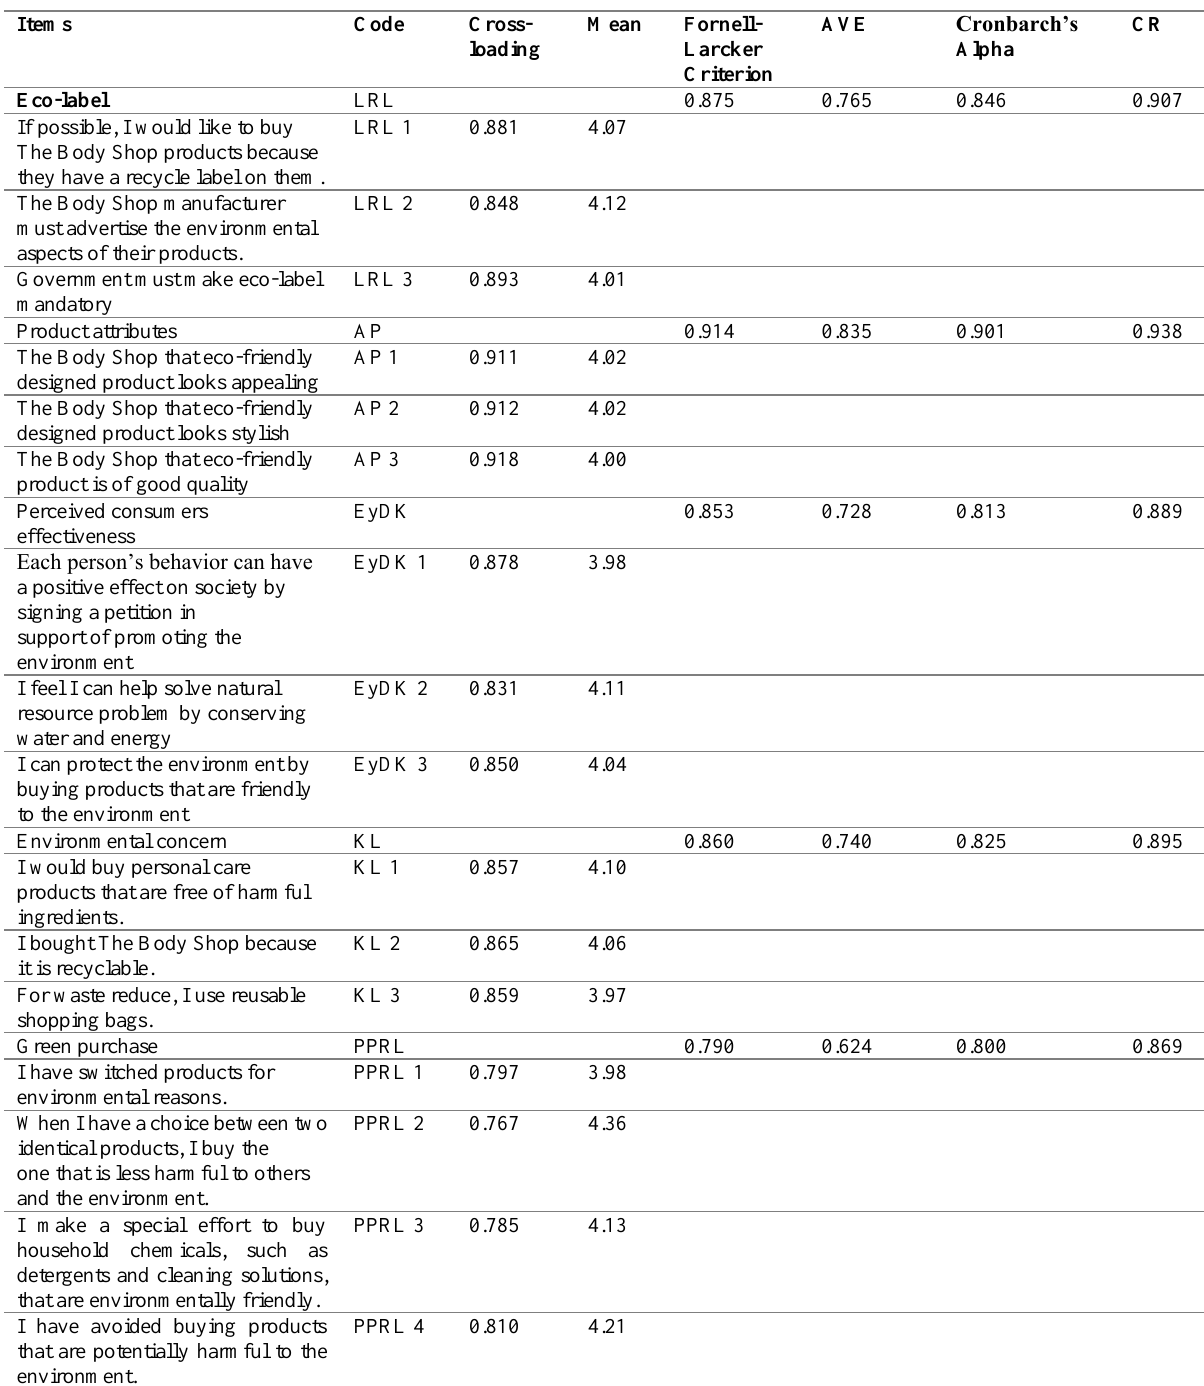
Table 2: Validity and